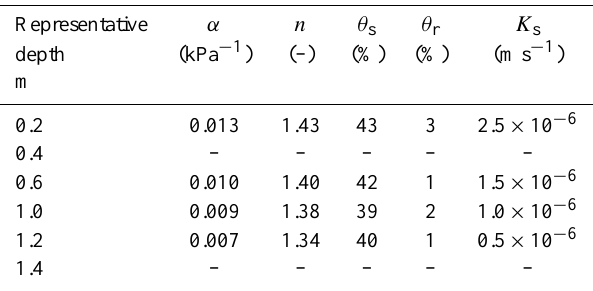
Table 2. Hydrological properties of the monitored slope soil and weathered